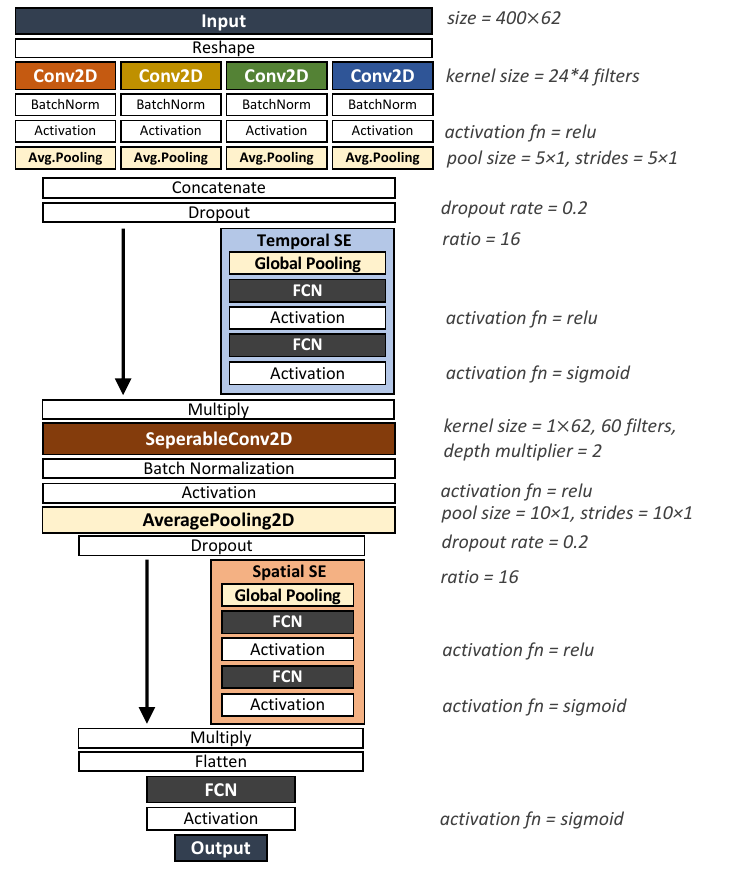
Figure 6. MultiT-S ConvNet model